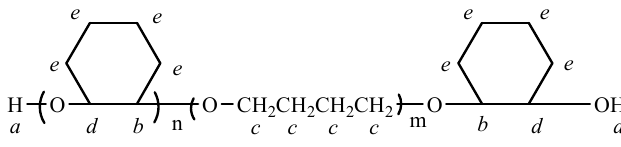
Figure 4. Structure analysis of the synthetic copolyether.